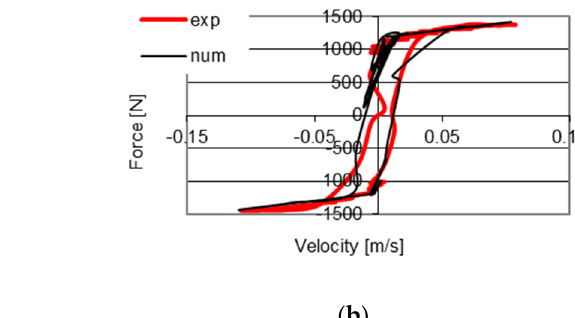
( b ) Figure 4. Results of numerical research on the MR damper model, ( a ) plane: force – displacement, ( b ) plane: force – velocity. On the basis of the conducted numerical research, the dissipative characteristics of the MR damper model were obtained. Similar to the characteristics regarding the